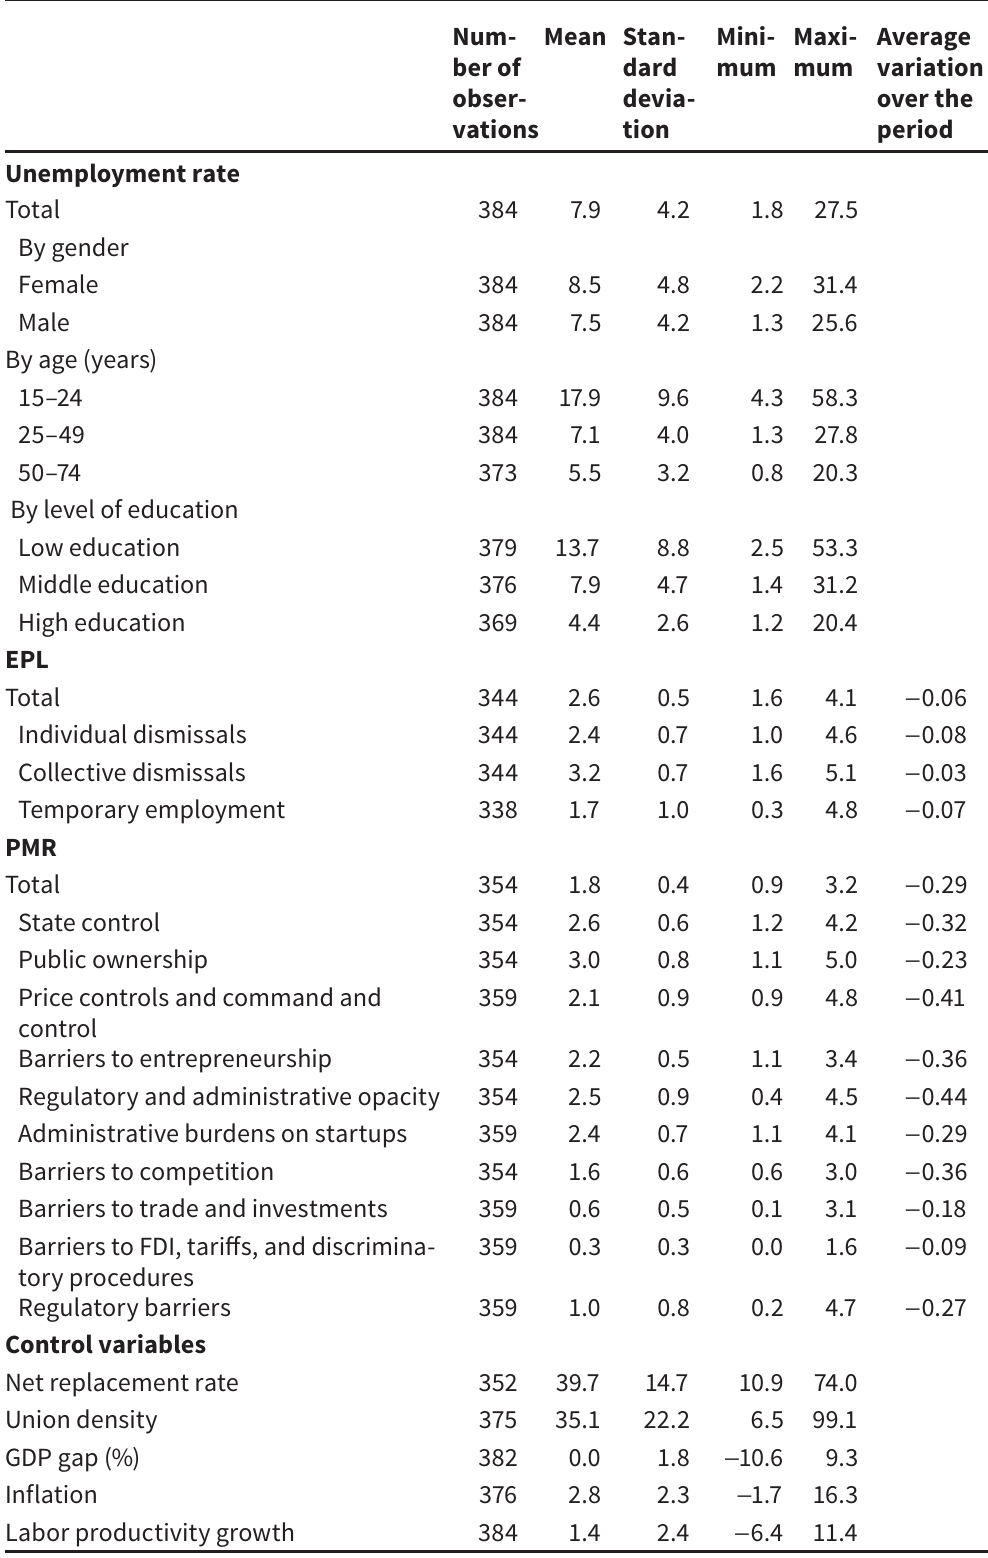
Table S2 Descriptive statistics